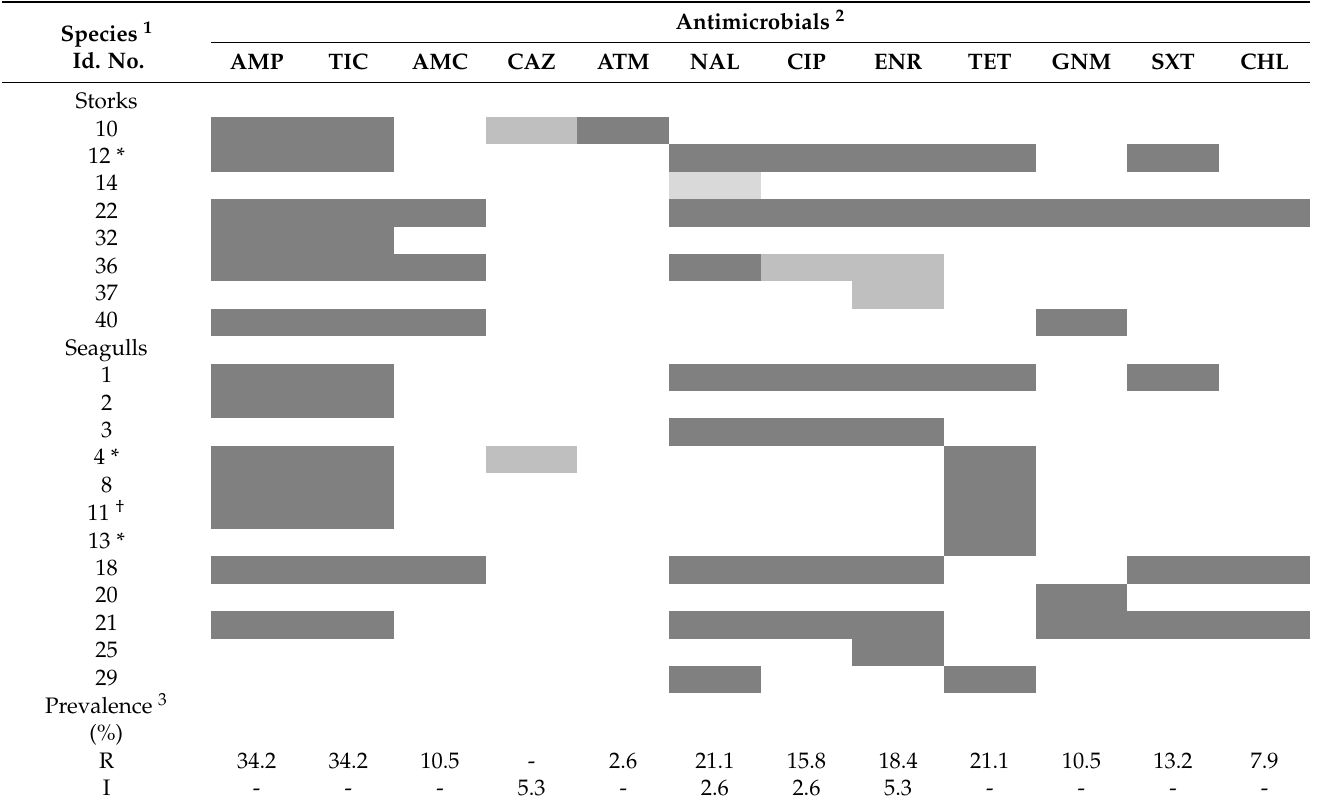
Table 2. Phenotypic profiles of antimicrobial resistance in Escherichia coli by species and overall prevalence of resistant or intermediate